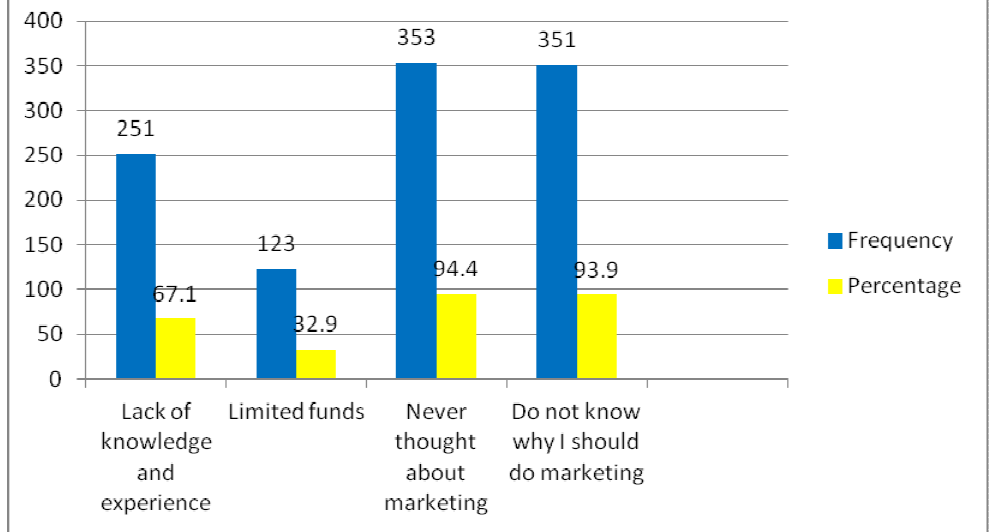
Figure 3: Factors influencing respondents’ marketing